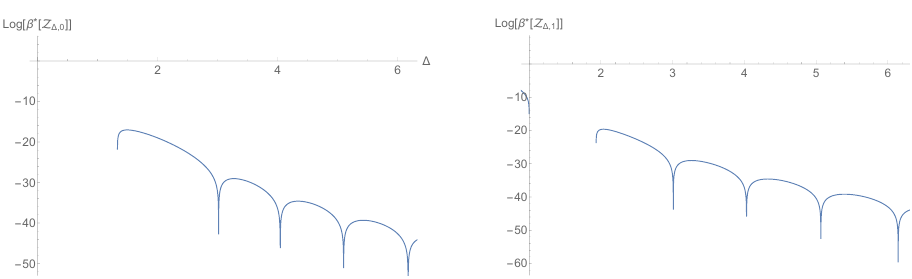
Figure 15. The extremal functional (cid:12) (cid:3) acting on spin-0(left) and spin-1(right) primaries at c = 16 and (cid:1) t = 2, without the spin-1 conserved current.